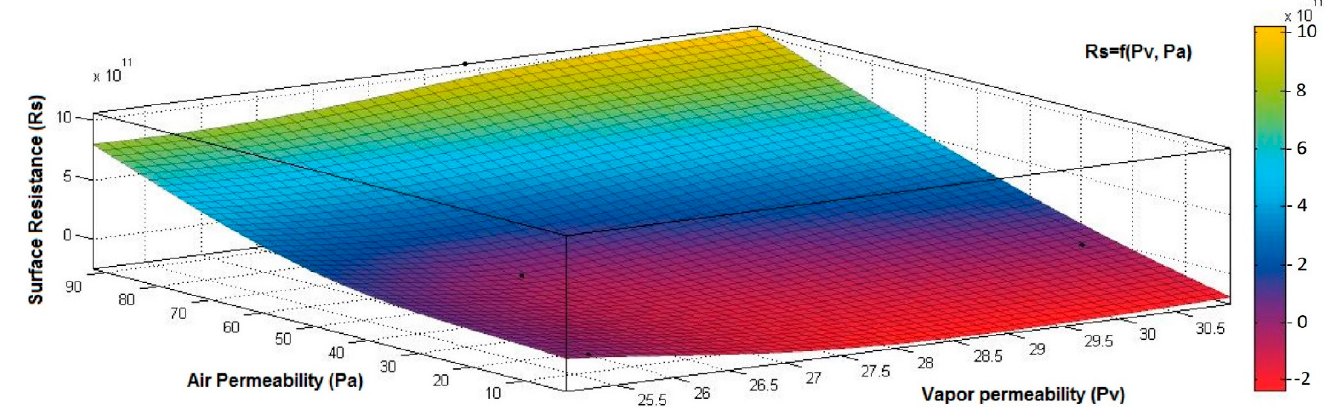
Figure 15. 3D representation Rs = f( Pa , Pv ) samples coated with a conductive polymeric paste-based PVDF.